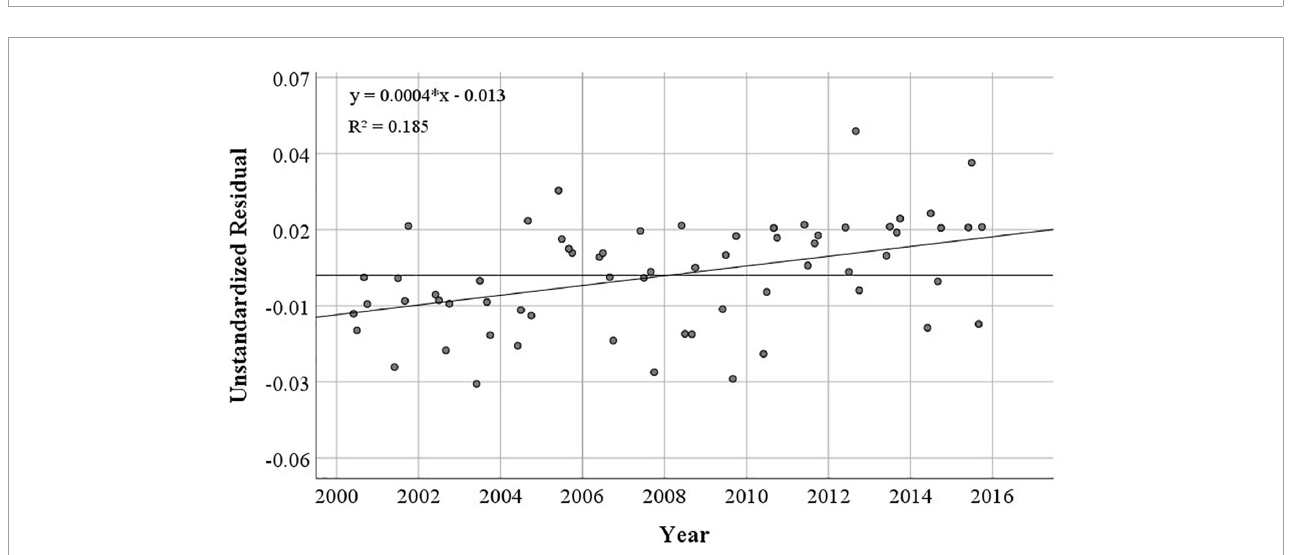
FIGURE7 The temporal trend of unstandardized